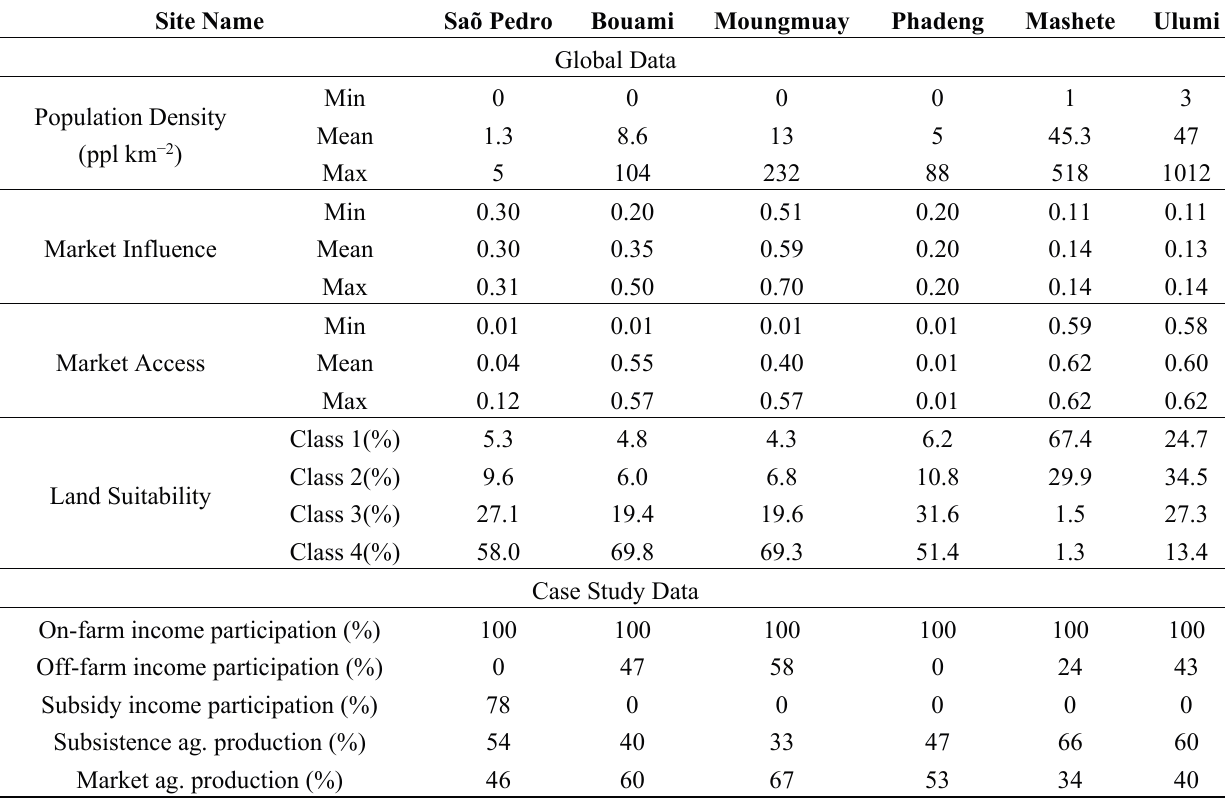
Table 1. Descriptive data for each test case consisting of both demographic, environmental, and economic global data and livelihoods data reported in case